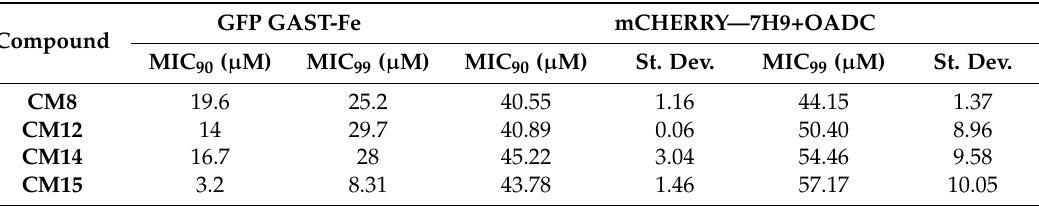
Table 2. Minimum inhibitory concentrations determined using two